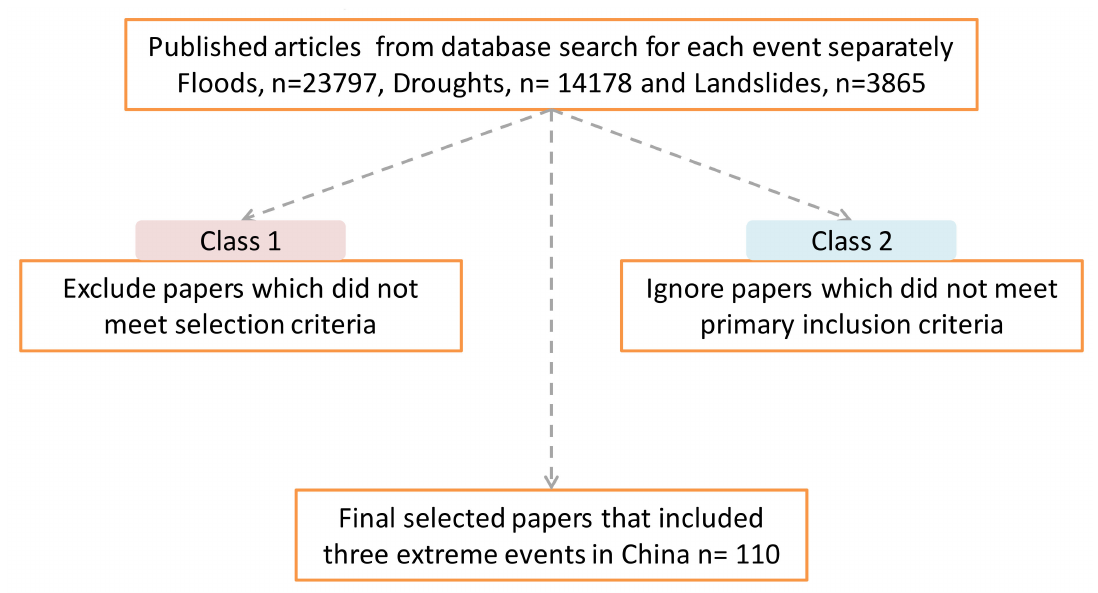
Figure 4. Flow chart of the article selection process. “n” stands for the number of